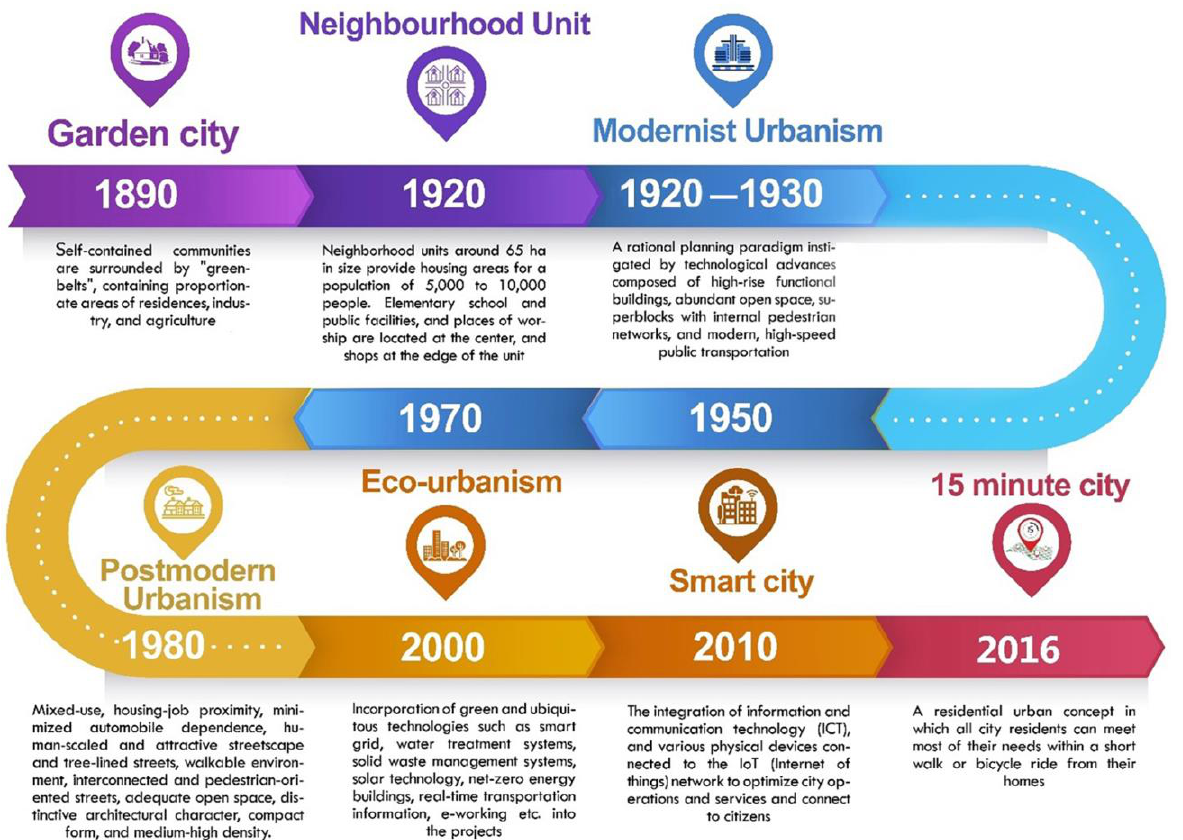
Figure 2. The historical sequence of neighborhood planning movements. Source: the authors.